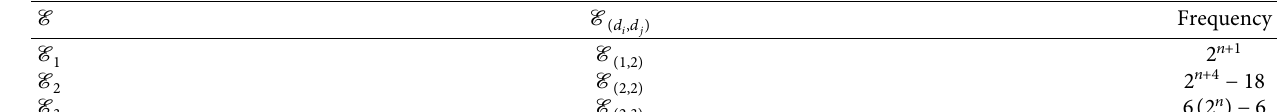
Figure 8: Propyl ether imine (PETIM) dendrimer. Table 4: Edge partitioning based on degree of PETIM.